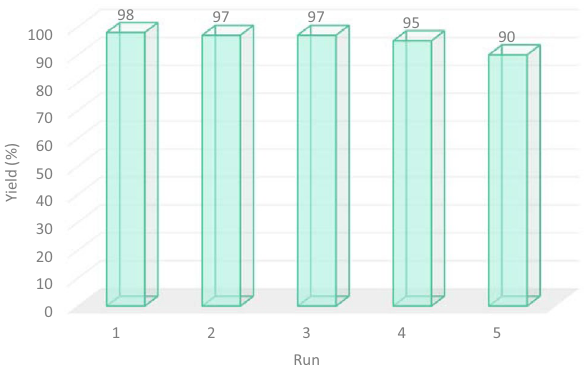
Figure 11. Reusability data for the magnetic Fe 3 O 4 @PMO-ICS-ZnO mesoporous catalyst ( 1 ) in the synthesis of 5a .